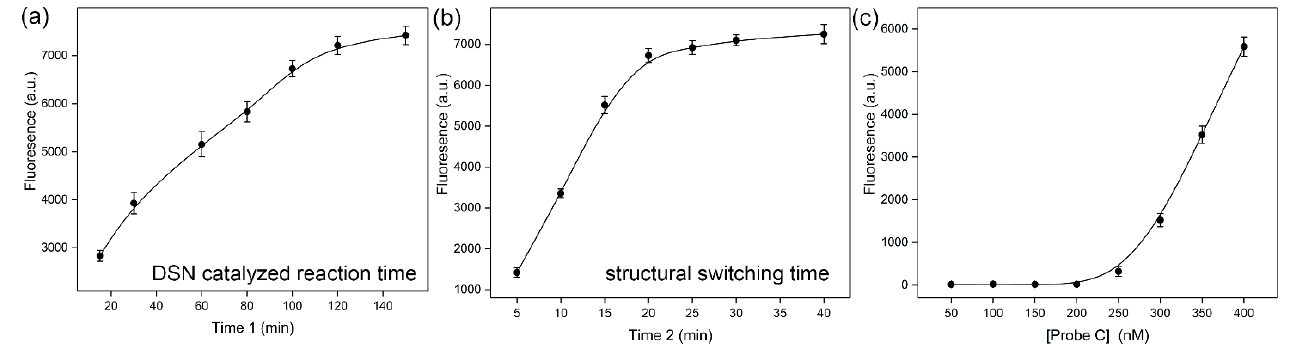
Figure 4. Optimization of ( a ) DSN catalyzed reaction time, ( b ) structural switching time, ( c ) Probe C concentration. MiRNA concentration of 1 nM and Probe C concentration of 200 nM are used for the optimization of reaction times.